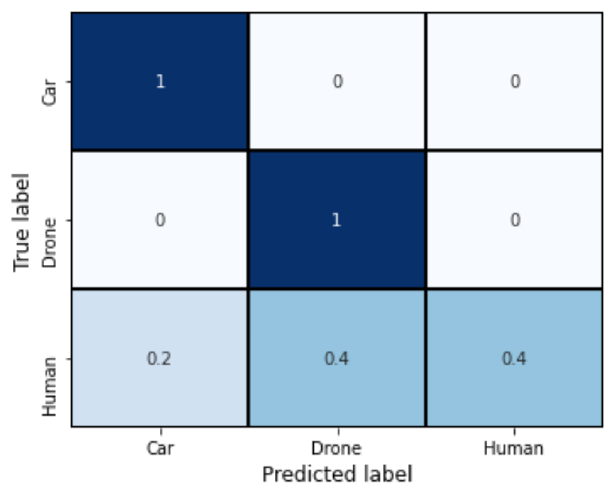
Figure 13. Confusion matrix of Naive Bayes model on test